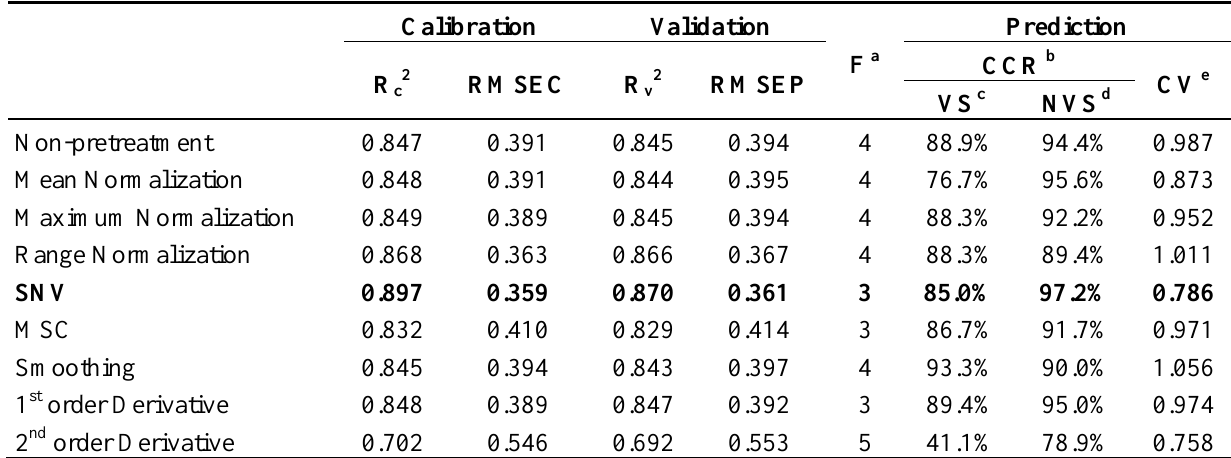
Table 2. Results obtained using the PLS-DA models based on the reflectance spectra with GL illumination (500–600 nm).